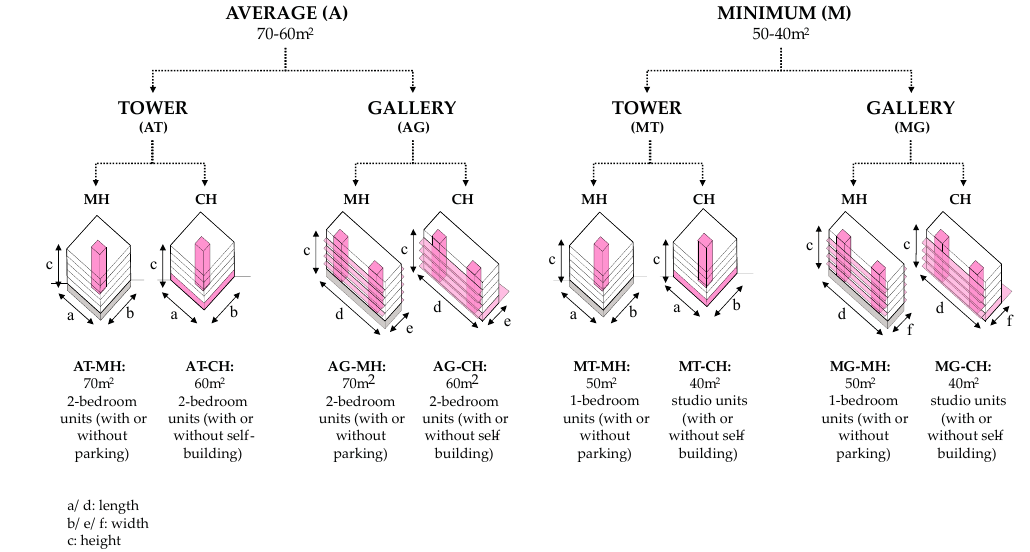
Figure 1. Diagram illustrating the chosen typologies and dwelling types used in the simulation (Source: Authors).